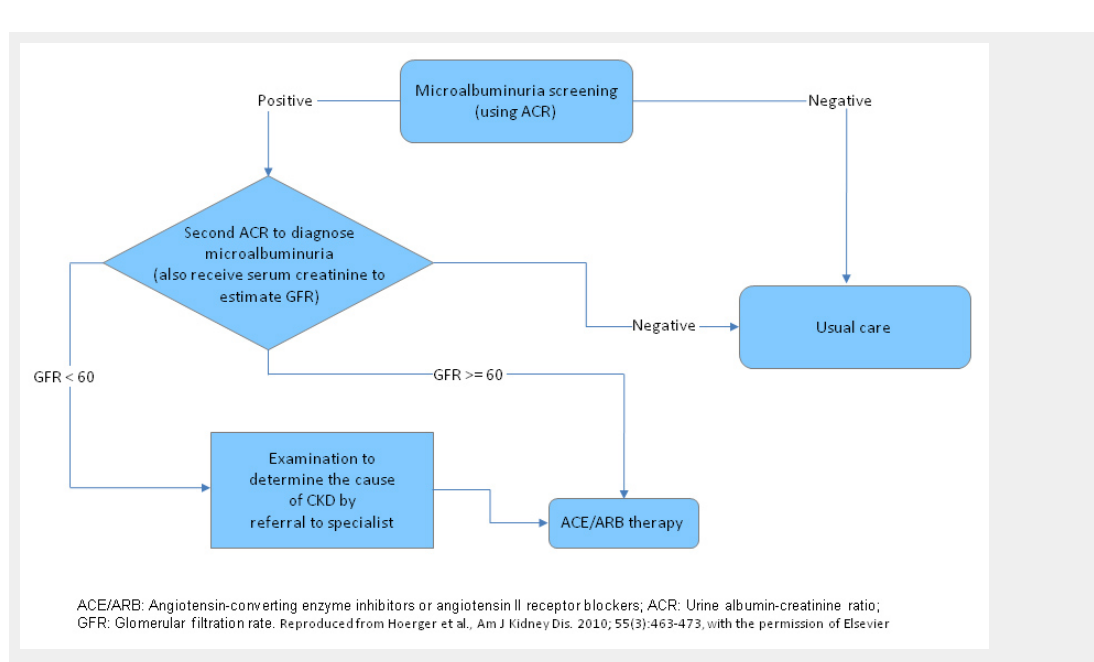
Figure 1 Scheme of screening and treatment interventions. ACE/ARB: Angiotensin-converting enzyme inhibitors or angiotensin II receptor blockers; ACR: Urine albumin-creatinine ratio; GFR: Glomerular filtration rate. The same screening and treatment scheme does apply for patients with macroalbuminuria. Such patients will also be detected in a microalbuminuria screening. Modified and reproduced from Hoerger TJ, Wittenborn JS, Segel JE, Burrows NR, Imai K, Eggers P, et al.Am J Kidney Dis. 2010:55(3):463–73, with the permission of Elsevier.